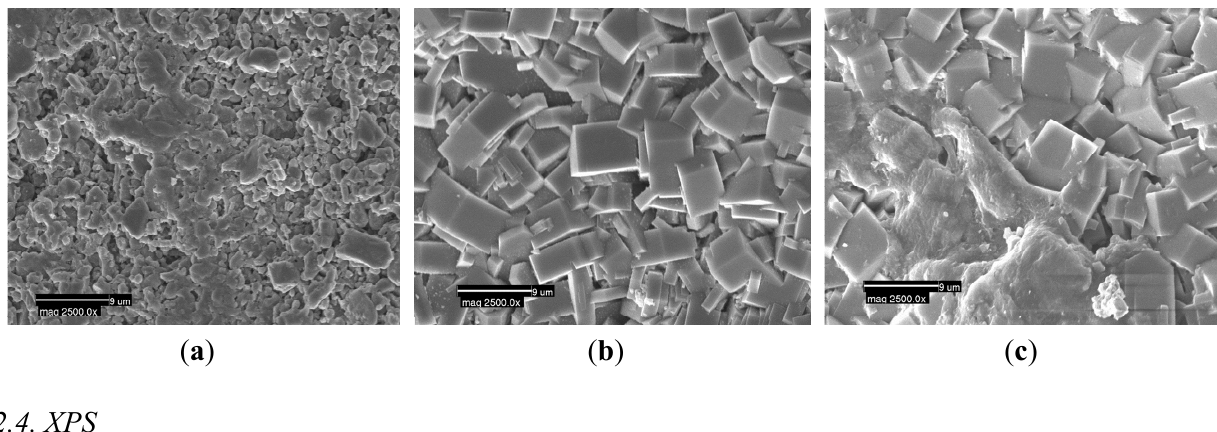
Figure 4. SEM images on the surface of ( a ) α -Al membrane; ( c ) desalination tested (~90 h) zeolite membrane.